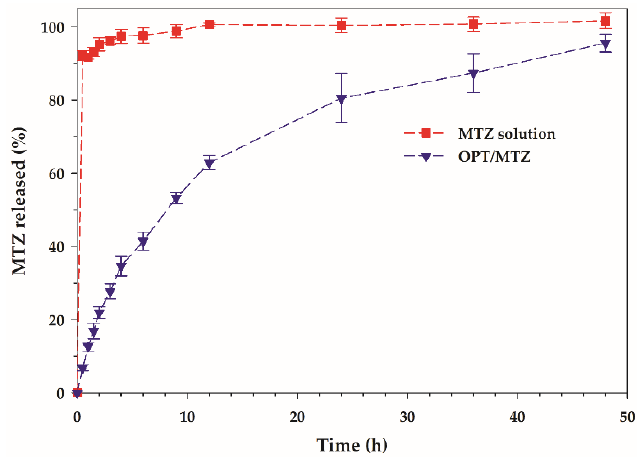
Figure 7. In vitro drug release profile of MTZ from MTZ solution and OPT/MTZ.